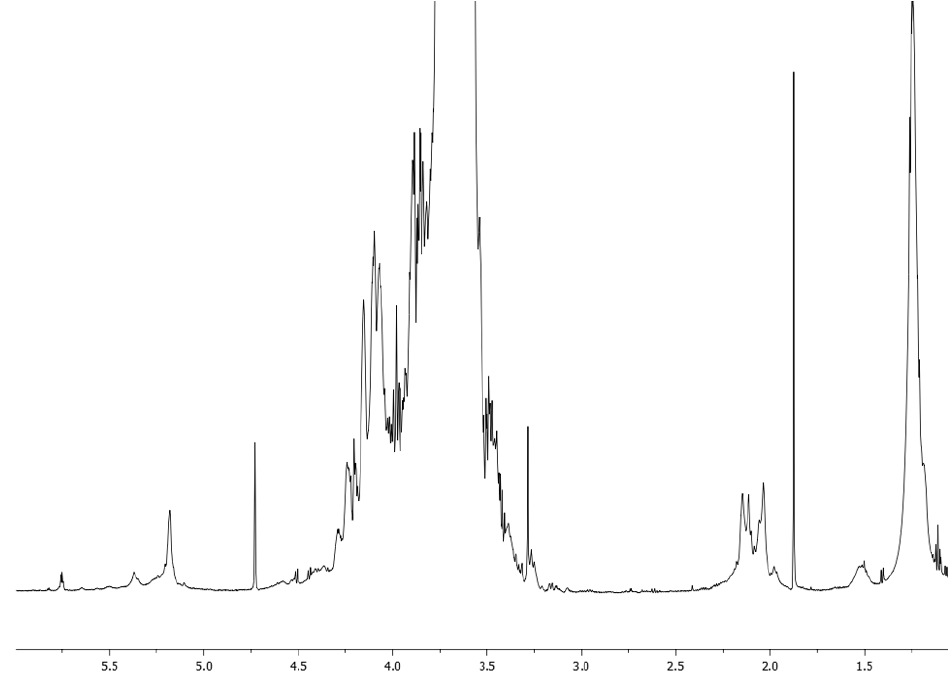
Figure 7. 1 H NMR spectrum of EPSC.2, recorded at 700 MHz in D 2 O. 2D HSQC spectrum of fraction EPSC.2 (Figure 8) confirmed the results obtained by 13 C NMR in solid state recorded on EPSC and 1 H NMR in D 2 O solution. In fact, signals at δ 110–